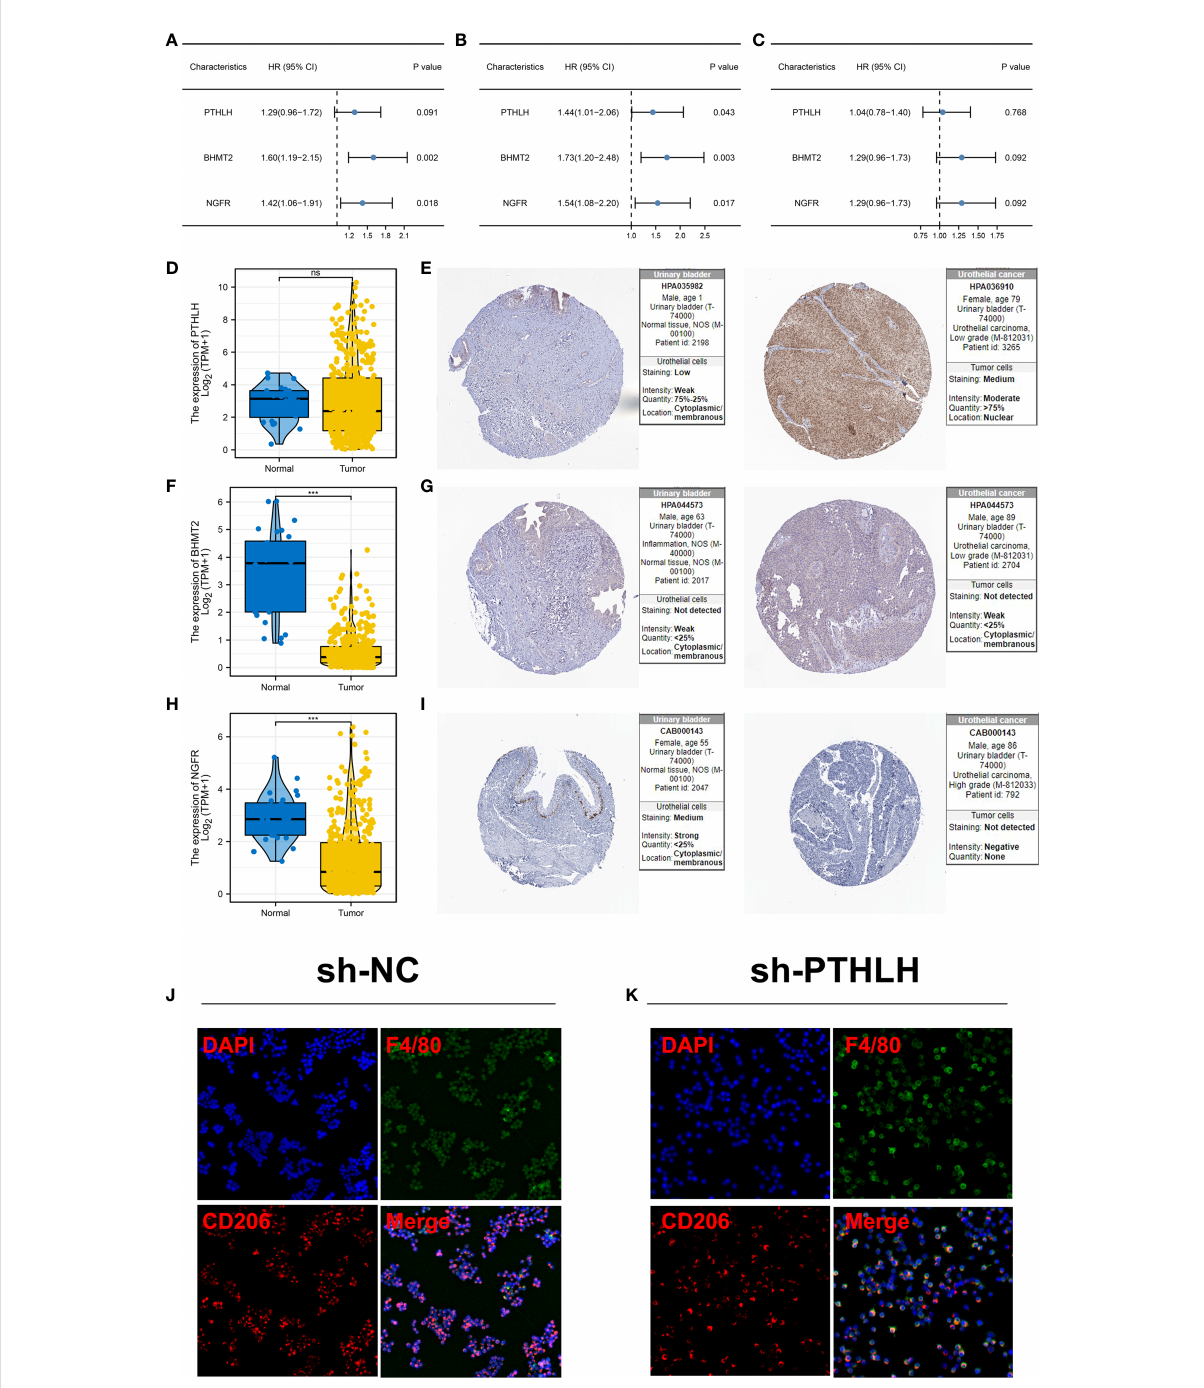
FIGURE 8 Further exploration of PTHLH, BHMT2, and NGFR (A) Prognosis correlation of PTHLH, BHMT2, and NGFR in overall survival. (B) Prognosis correlation of PTHLH, BHMT2, and NGFR in disease-free survival. (C) Prognosis correlation of PTHLH, BHMT2, and NGFR in progression-free survival. (D) Expression level of PTHLH in normal bladder and bladder cancer tissue in mRNA level. (E) Representative immunohistochemistry image of PTHLH protein level in normal bladder and bladder cancer tissue. (F) Expression level of BHMT2 in normal bladder and bladder cancer tissue in mRNA level. (G) Representative immunohistochemistry image of BHMT2 protein level in normal bladder and bladder cancer tissue. (H) Expression level of NGFR in normal bladder and bladder cancer tissue in mRNA level.; (I) Representative immunohistochemistry image of NGFR protein level in normal bladder and bladder cancer tissue. (J, K) Knockdown of PTHLH in bladder cancer cells can signi fi cantly inhibit the M2 polarization of co-culture M0 macrophages. ***P < 0.001. ns: P >